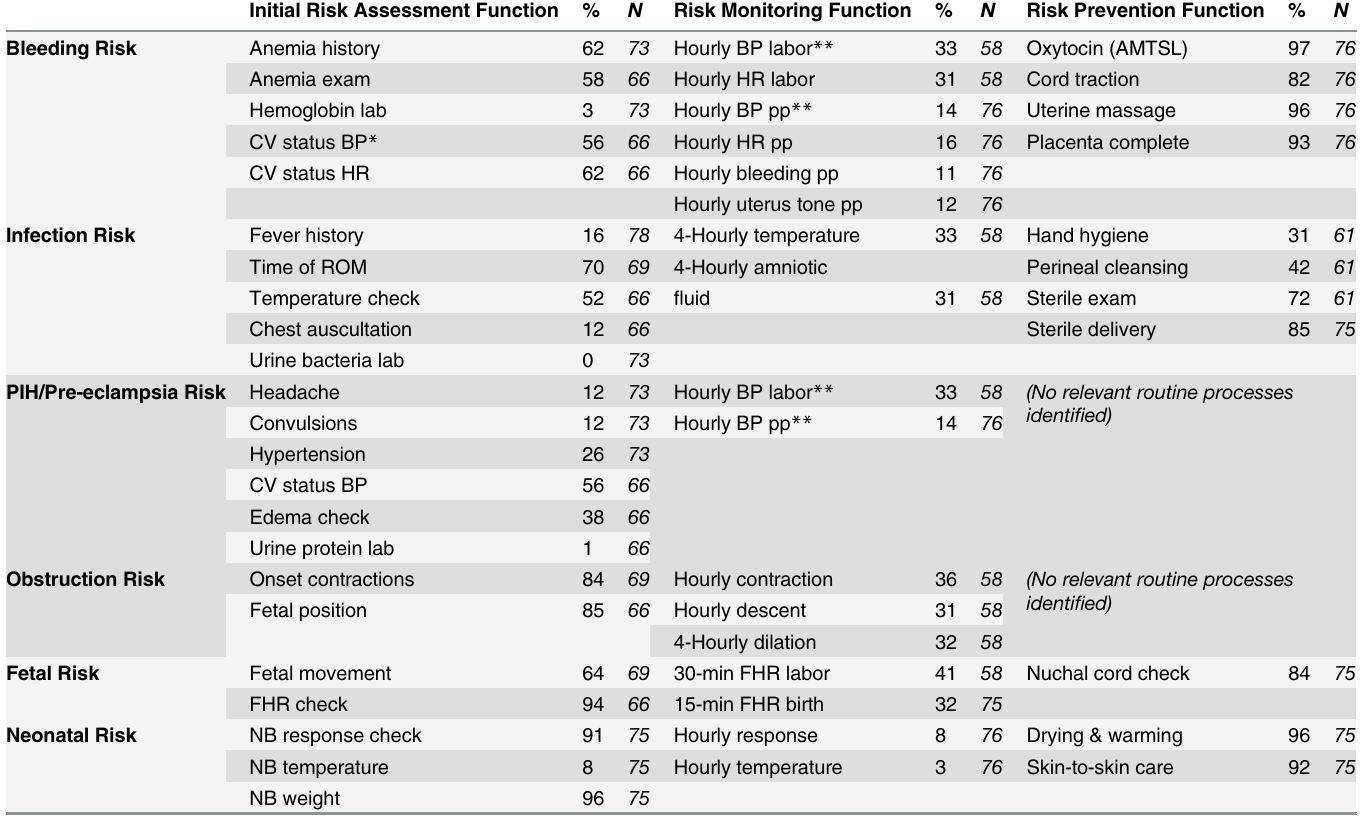
Table 2. Observed frequencies of routine care processes by clinical core function and complication